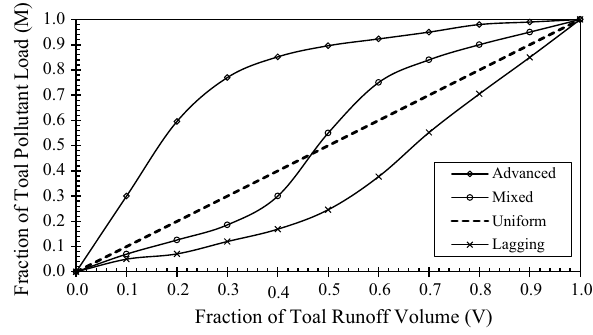
Fig. 1 Typical loading characteristics of